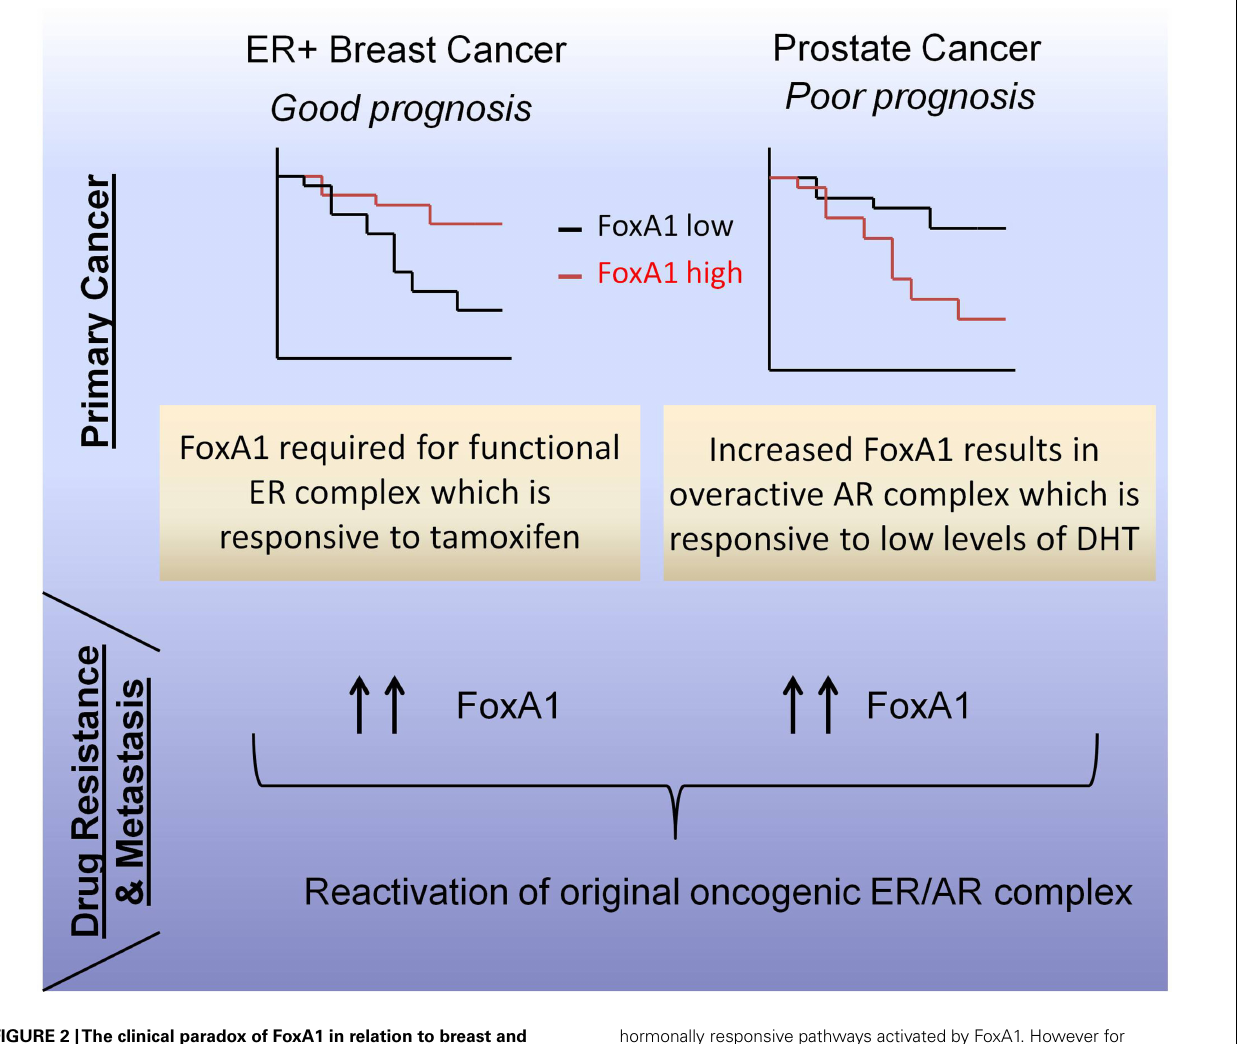
FIGURE 2 |The clinical paradox of FoxA1 in relation to breast and prostate cancer. FoxA1 is a good prognostic marker in ER + breast cancer yet in prostate cancer is a marker of poor outcome as indicated by the hypothetical survival curves.This may be due to differences in the